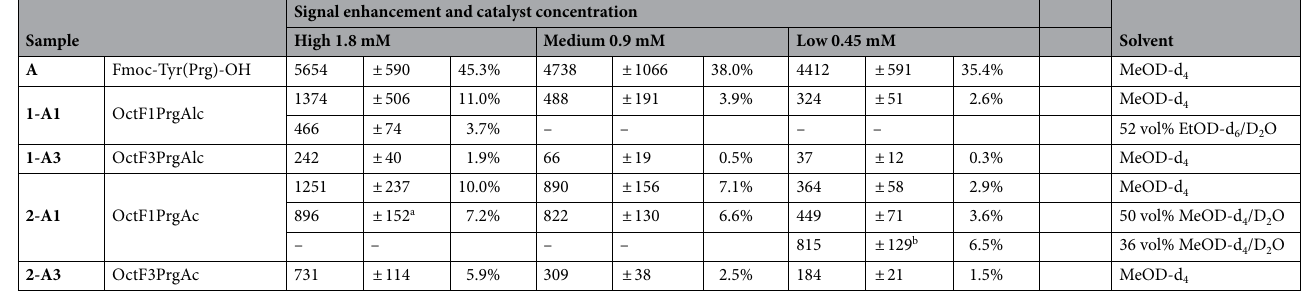
Table 1. Average signal enhancements of H B and corresponding polarization % at different catalyst concentrations and solvent compositions, for PHIP-marker A and modified octreotide derivatives 1/2-A1 and 1/2-A3. Averages for A are based on two measurements, and for the peptides on three measurements respectively. a Concentrations of analyte and catalyst were reduced by a factor of 0.77, already considered in SE. b Concentration of analyte was 1.2 mM, already considered in